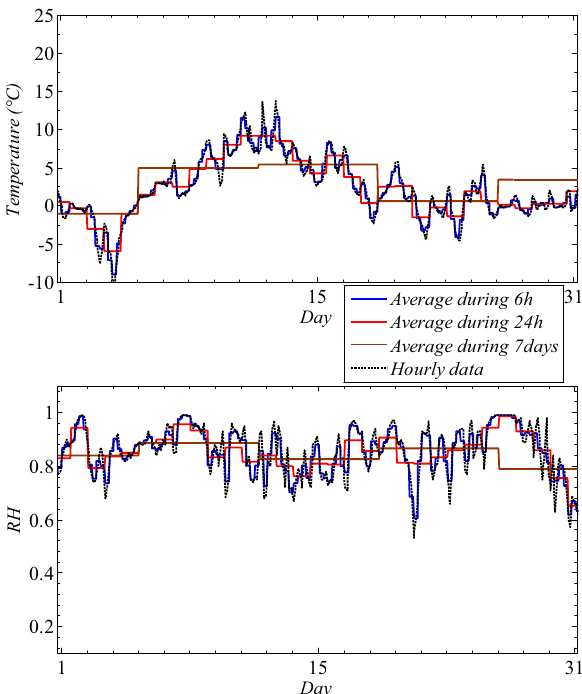
Fig. 9 Environmental data averaged during various time- steps for a month in Strasbourg, France.